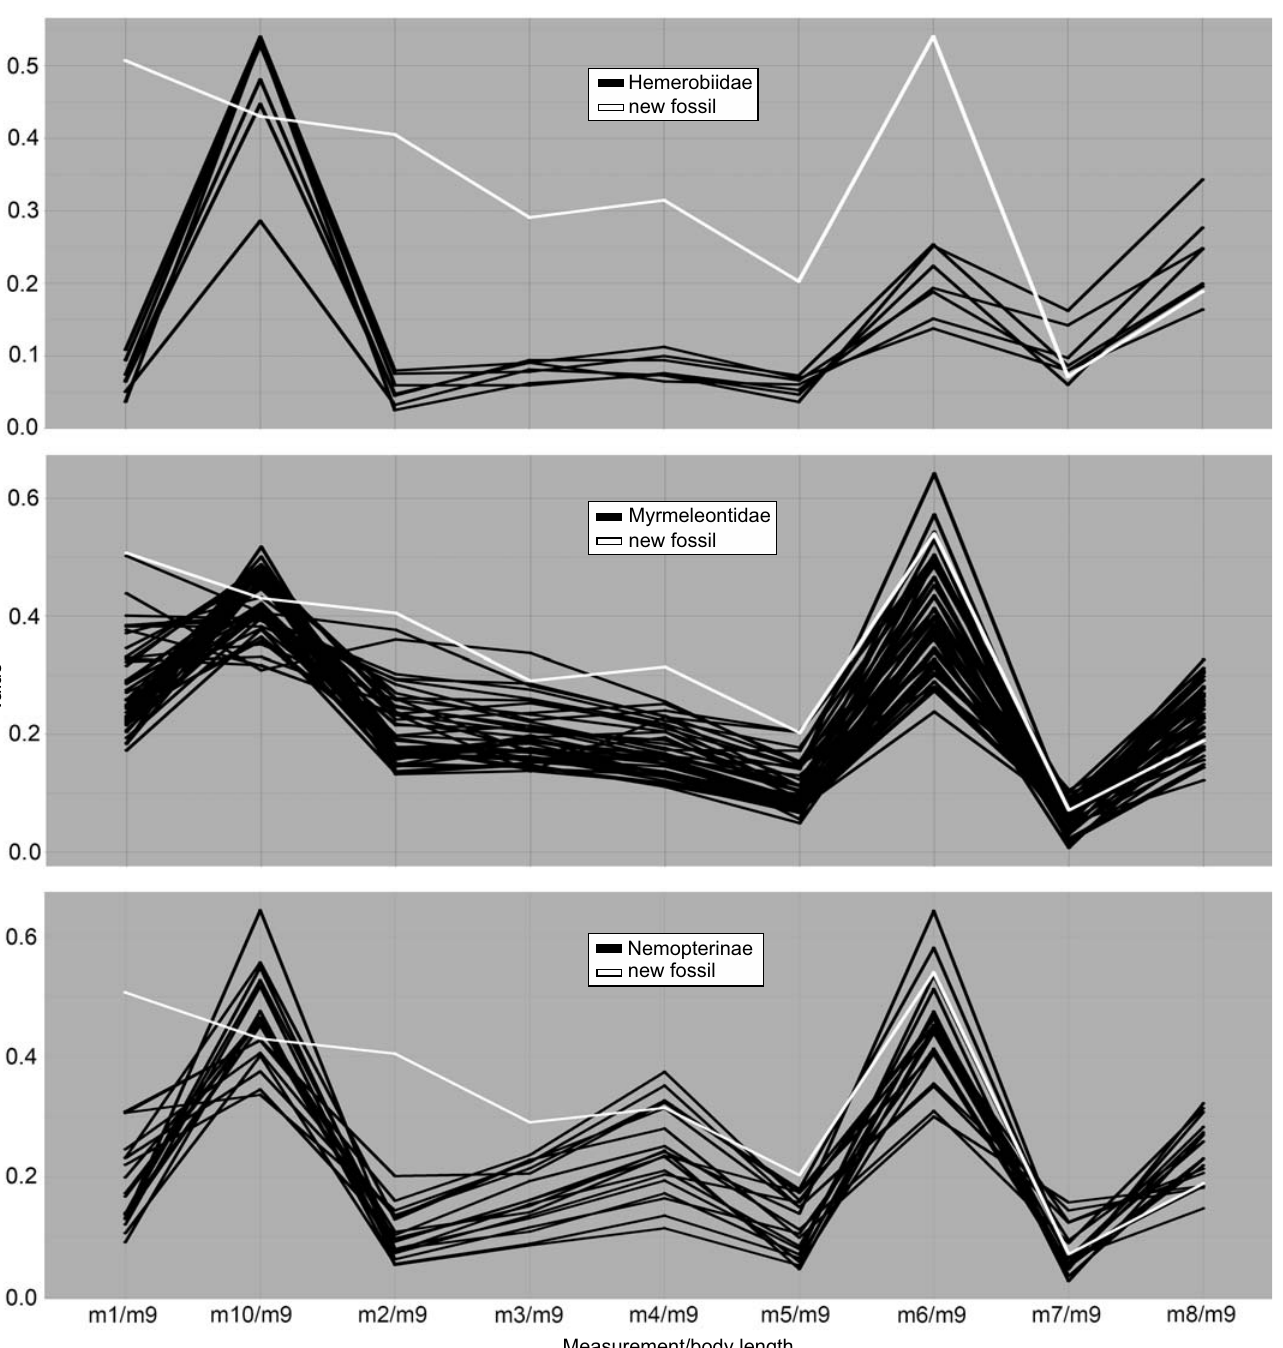
Fig. 6. Parallel coordinates plot for larvae of Hemerobiidae (brown lacewings), Myrmeleontidae (antlions), and Nemopterinae (spoon-winged lacewings). White line represents MfN MB.I